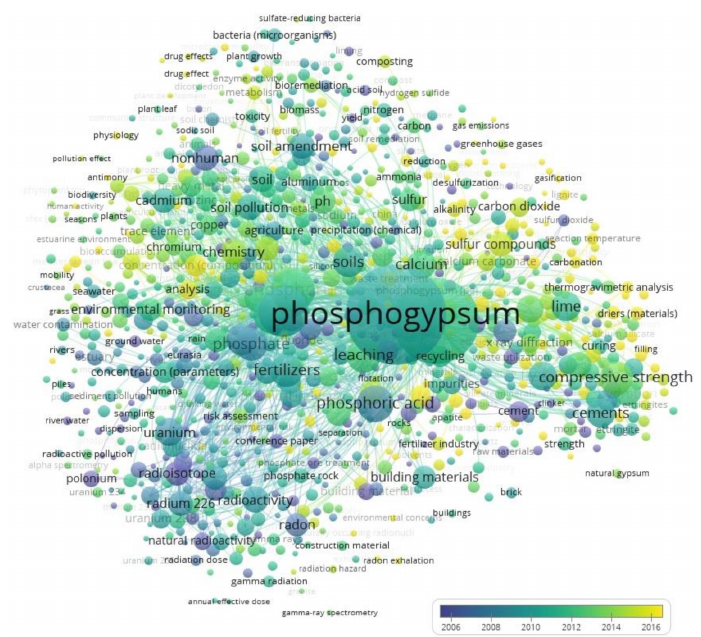
Figure 8. Overlay visualization of most frequent terms (constructed via VOSViewer v.1.6.15), where the score of the item is the time since